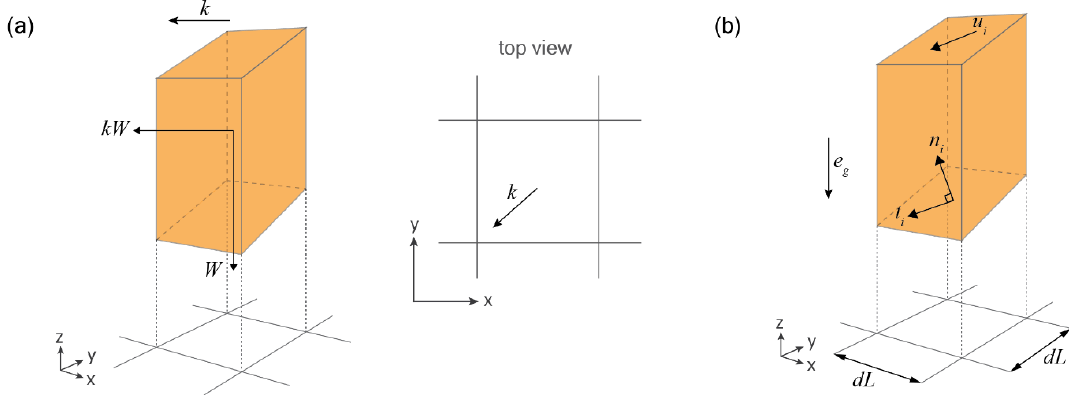
Figure 3. Diagram of soil mass components. (a) Design horizontal seismic intensity and direction of the soil mass. (b) The shape of the soil mass and directional vectors used for calculation.